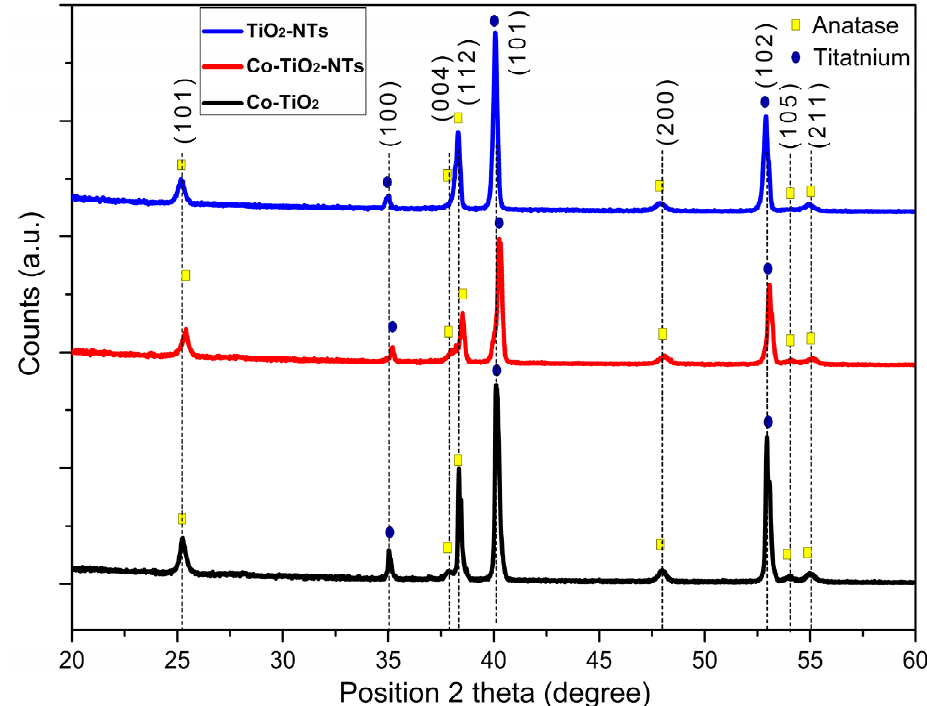
Figure 2. Comparison of XRD patterns of titanium samples covered with TiO 2 nanotubes pure and with cobalt doping.